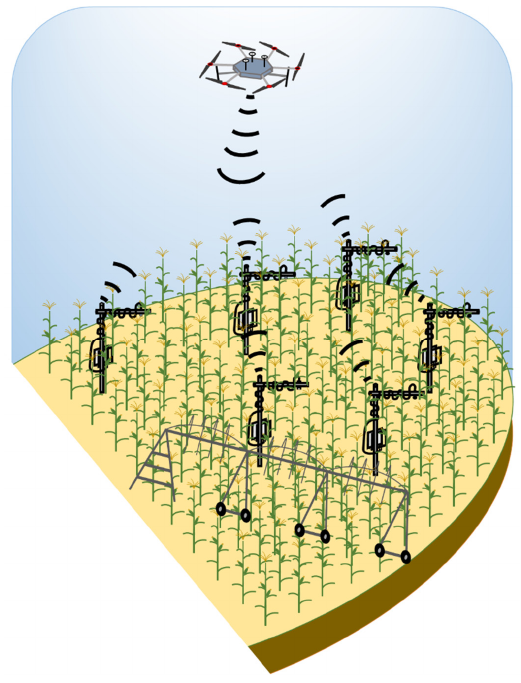
Figure 2. A schematic diagram of airborne based unmanned aerial system data ferry communicating with stationary sensor node stations on the ground installed in maize over a center-pivot irrigated field near Mead, Nebraska.